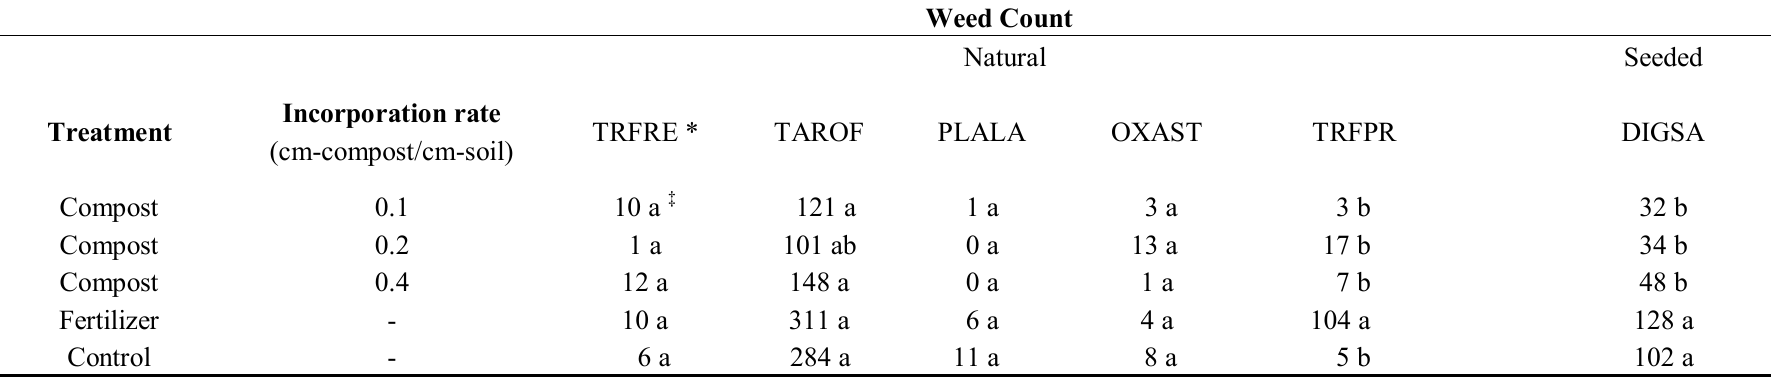
Table 3. Number of naturally occurring weeds and manually seeded large crabgrass seeds in sodded turf